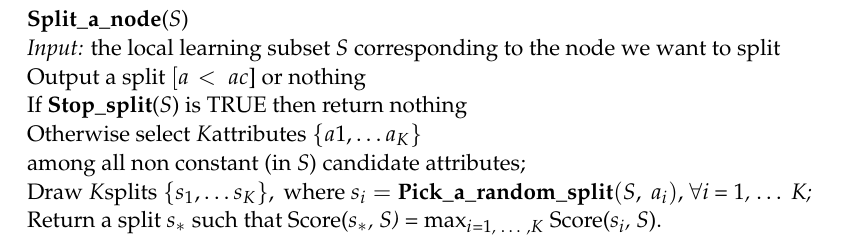
Algorithm A6 Extra-Trees Splitting Algorithm